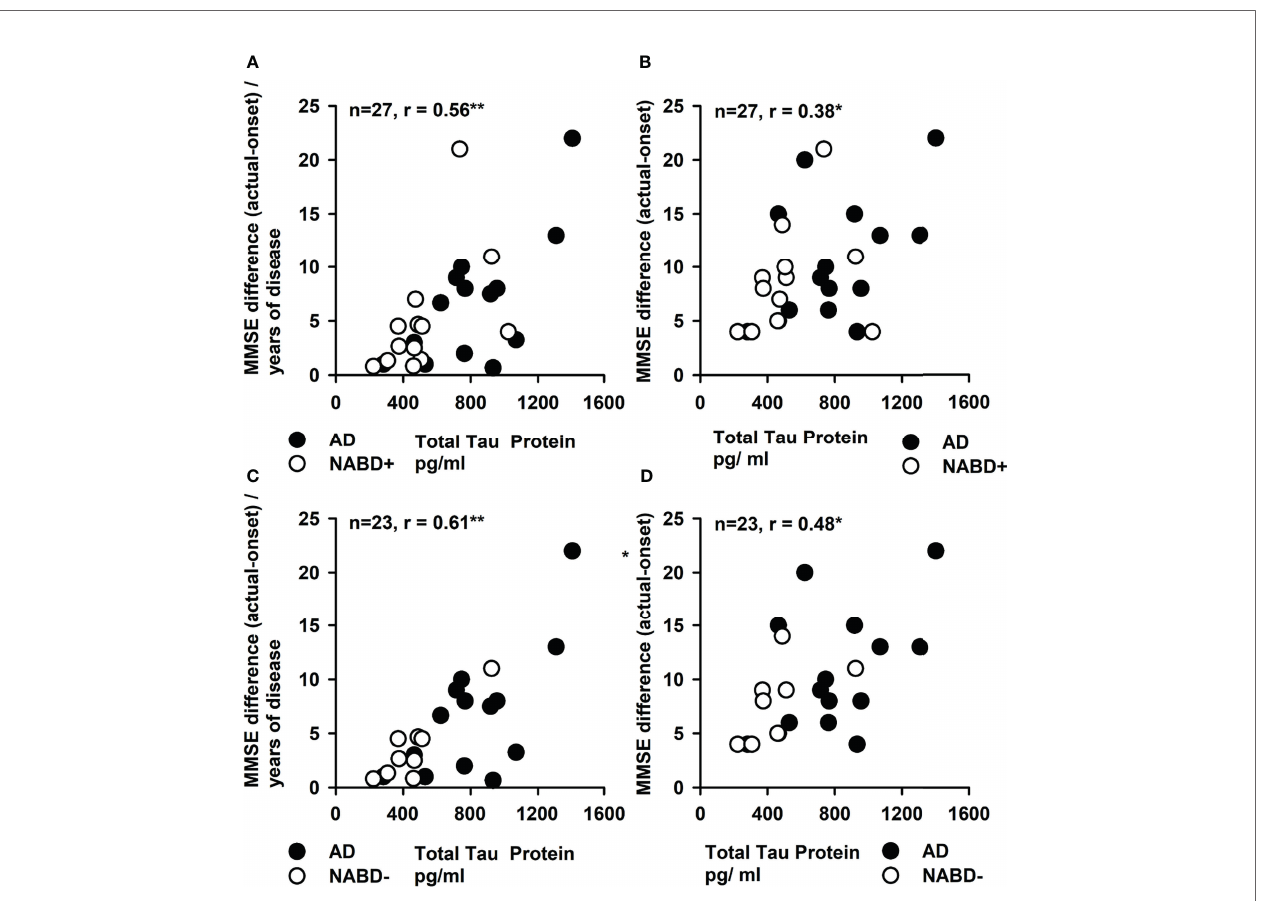
FIGURE 3 | Correlation of cerebrospinal fl uid total tau protein and yearly and total progression of cognitive dysfunction. The yearly progression of cognitive dysfunction depicted as mean Mini-Mental State Examination (MMSE) difference between the MMSE at disease onset and current MMSE (MMSE difference) divided per year was strongly correlated with the total tau protein in CSF in (A, C) . (B, D) The total tau protein in cerebrospinal fl uid (CSF) is correlated with the MMSE difference. In all fi gures, both groups [NABD+ and AD (A, B) as well as NABD − and AD (C, D) ] are correlated as one group between total tau protein and yearly and total progression of cognitive decline. AD, Alzheimer ’ s dementia; NABD+, neural autoantibody-associated dementia including patients with CSF-based Alzheimer ’ s disease pathology; NABD − , anti-neural autoantibody-associated dementia without cerebrospinal fl uid-based Alzheimer ’ s disease pathology. *p < 0.05, **p <